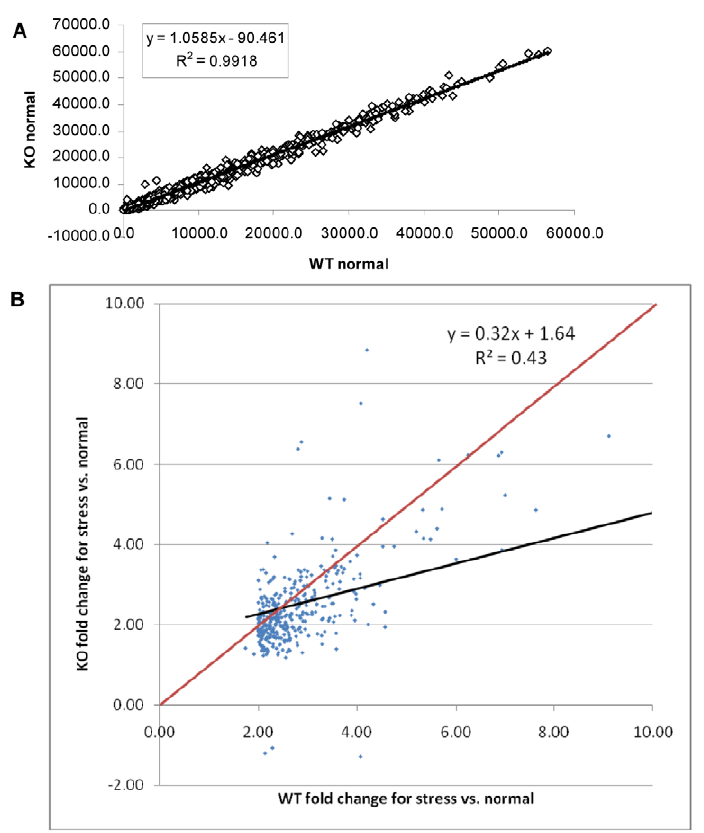
Figure 3. D GCN5-A parasites fail to up-regulate alkaline pH response genes. A. Scatter plot of expression levels for D GCN5-A (KO – vertical axis) vs. wild-type (WT –horizontal axis) under normal conditions. Data limited to those genes with fraction present $ 0.5 in WT or KO. B. Scatter plot of wild-type (WT) vs. D GCN5-A knockout (KO) fold changes. Probe sets limited to those with maximum fraction present $ 0.5, p , 0.01 and fold $ 2.0 for WT stress vs. normal culture conditions. Regression line is in black. All points below the red line are genes with smaller fold changes in KO than in WT for stress vs. normal culture conditions.